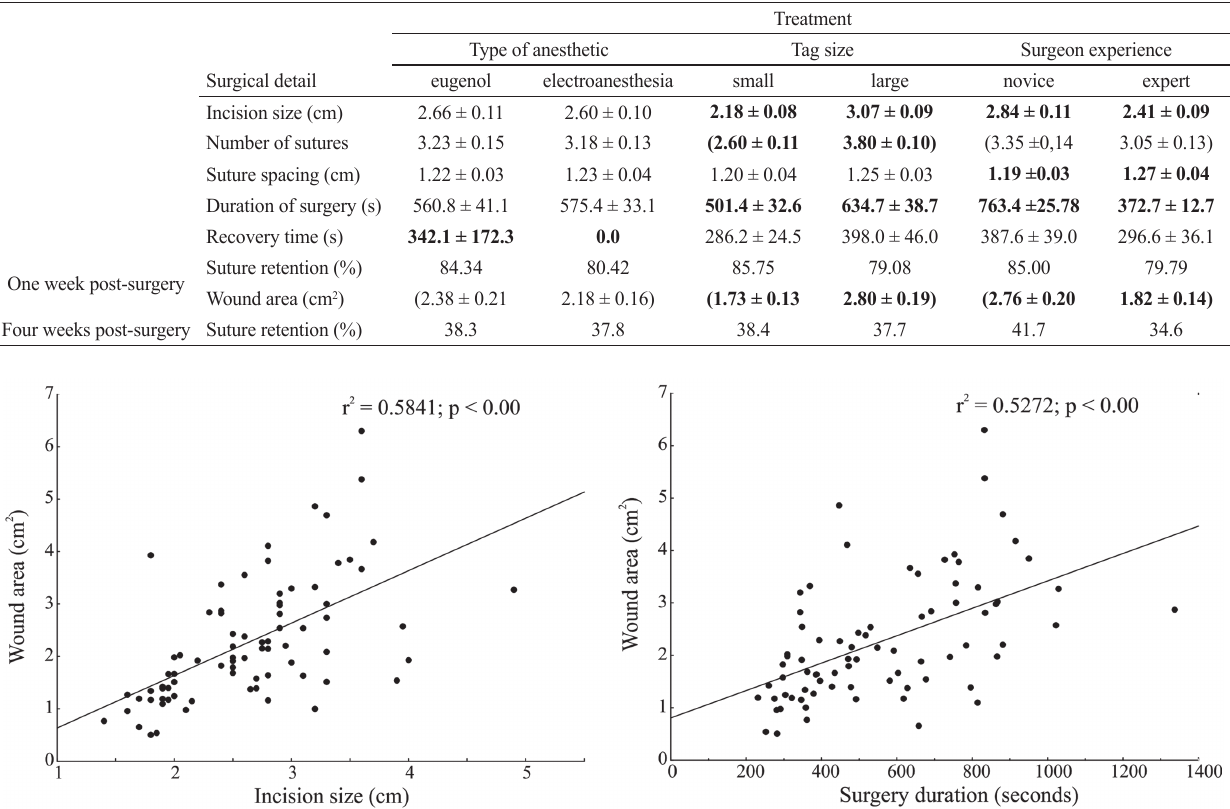
Table 3. Effect of type of anesthetic, tag size, and surgeon experience of Prochilodus lineatus on surgical details and postsurgical wound healing parameters (mean ± SD) one and four weeks post-surgery tested by Factorial ANOVA. Mean values in bold indicate single significant treatment differences. In parenthesis are indicated significant treatment differences when in interaction.